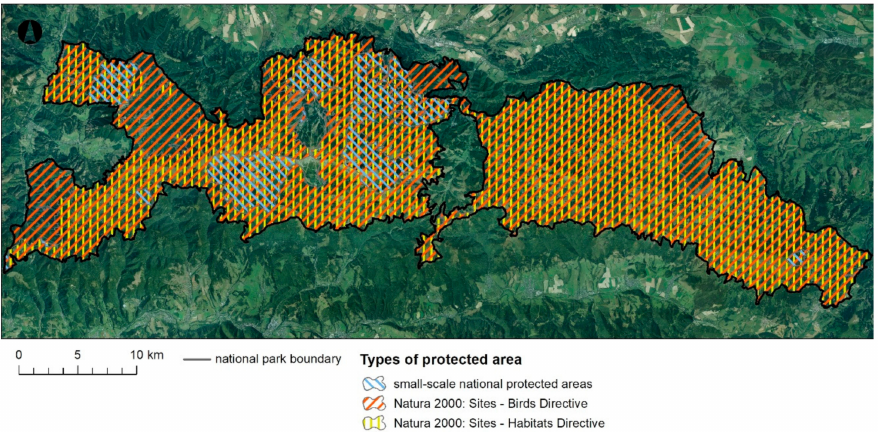
Figure 2. Protected areas of Low Tatras National Park.